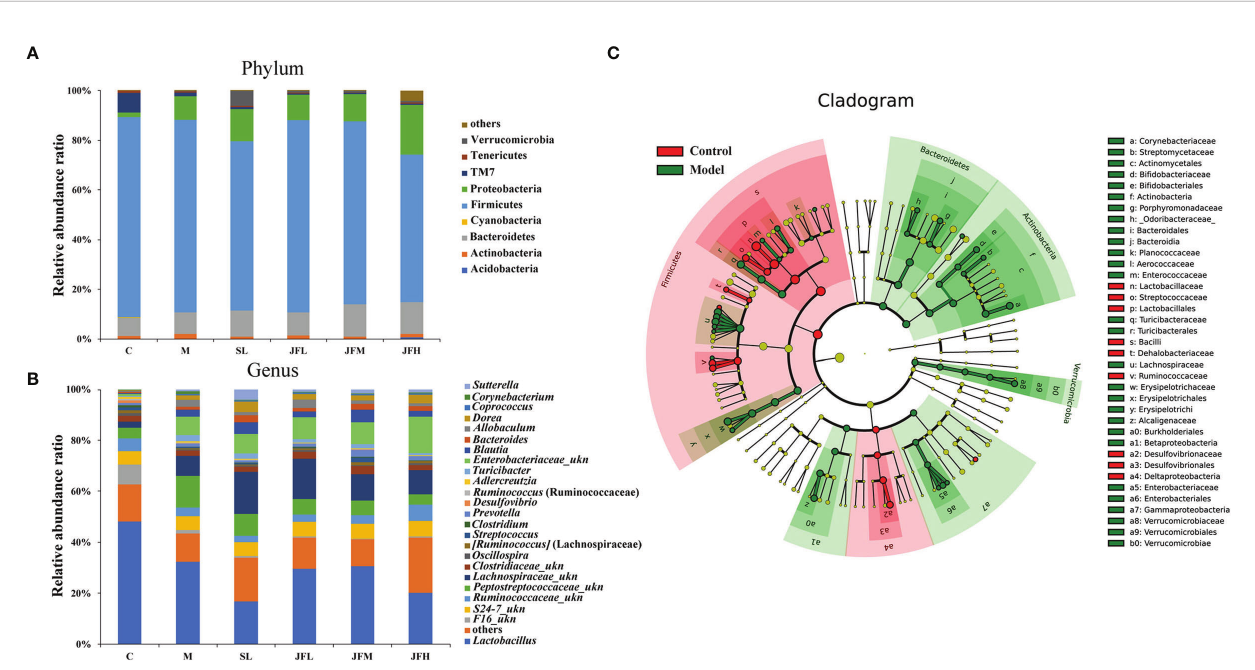
FIGURE 5 | Effects of JF extract on the structure of intestinal fl ora in spleen-de fi ciency rats. The percent of community abundance at the phylum (A) and genus (B) levels. LEfSe hierarchical tree (C) of between control group and model